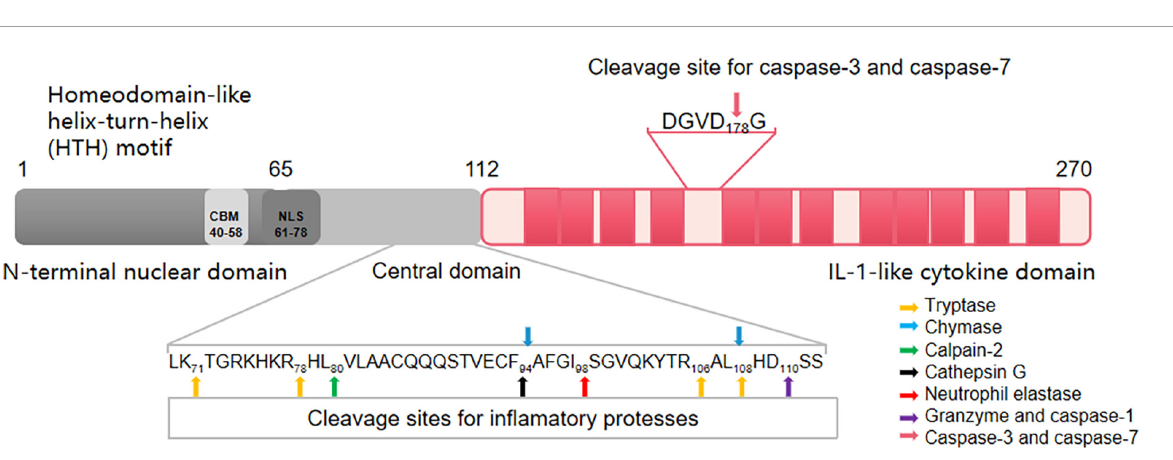
FIGURE2 The human IL-33 protein. Human IL-33 consists of 270 amino acids (aa). The protein includes the N-terminal nuclear localization signal, C-terminal IL-1-like cytokine domain, and intermediate divergence. The homeodomain-like helix-turn-helix (HTH) motif is constituted of aa 1–65 in the N-terminal region. Aa 40–58 in the N-terminal region of IL-33 form the chromatin-binding motif (CBM). CBM mediates IL-33 to bind to chromatin in a protein-protein interaction. The aa at positions 65–78 form the nuclear localization signal (NLS). Notably, CBM and NLS are critical for the nuclear localization of IL-33. Human mature IL-33 residues aa 112–270 (mouse mIL-33 residues aa 109–266). Many cleavage sites for inflammatory proteases (including chymase, tryptase, neutrophil elastase, cathepsin G, and elastase process) are found in the central domain